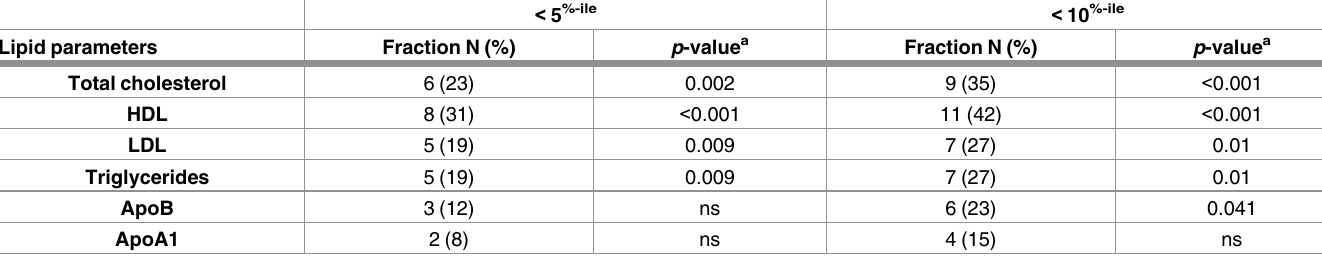
assess the relationship between lipid parameters and clinical profile. As shown on Table 3, neg- ative relationships were observed between several lipid parameters and ABC-C’s total or sub- domains scores. ApoB showed a statistically significant association with total score (r p = 0.044) in addition to hyperactivity (r s = -0.56, p = 0.005), stereotypy (r s = -0.46, p = 0.024) and language (r = -0.47, p = 0.020). When ABAS domain scores were correlated with lipid s parameters, positive associations reached significance for practical and conceptual domain with apoB (respectively r = 0.57, p = 0.004 and r = 0.41, p = 0.049) and apoA1 (respectively r s s = 0.52, p = 0.009 and r = 0.57, p = 0.004). Lp(a) levels did not differ between two groups. How- s ever, consistent associations were also observed between Lp(a) levels and conceptual domain (r = 0.53, p = 0.036), practical domain (r = 0.57, p = 0.004) as well as ABAS global score ( r s s 0.51, p = 0.013).